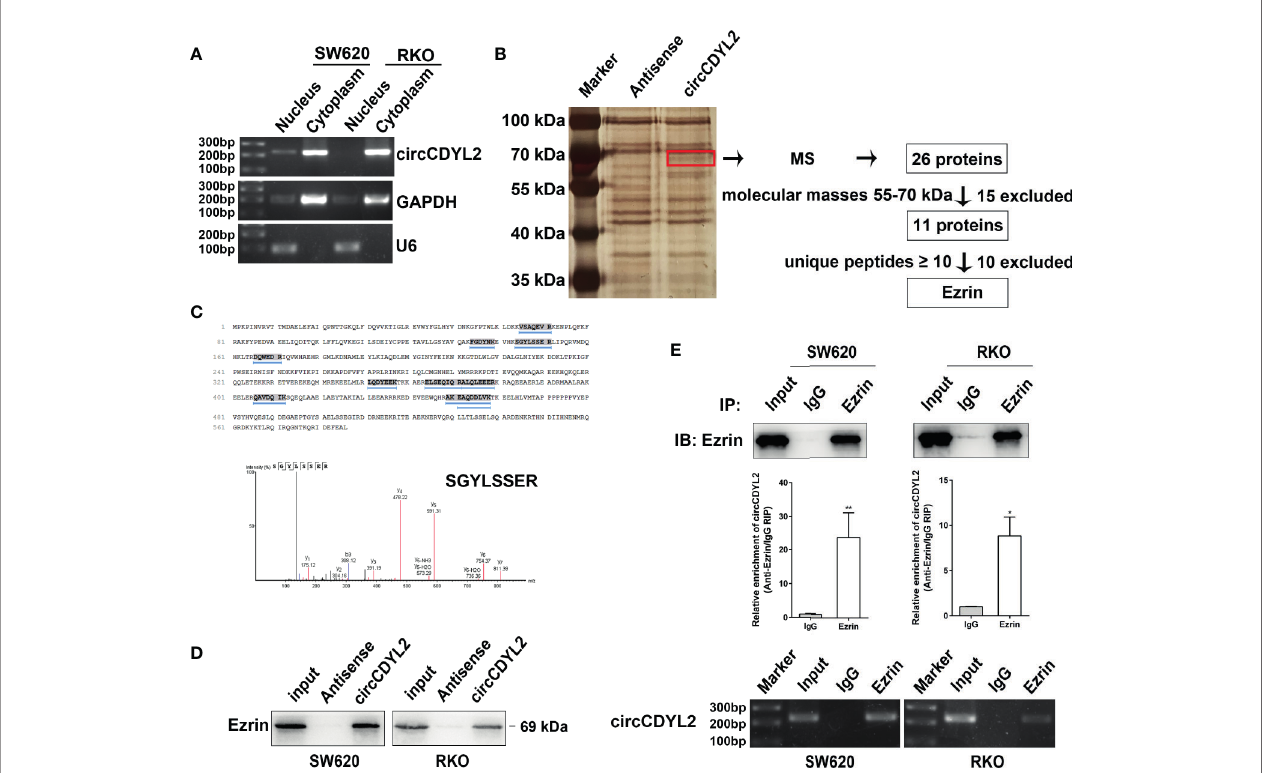
FIGURE 5 | CircCDYL2 mainly resided in the cytoplasm of CRC cells and bound to Ezrin. (A) The nuclear and cytoplasmic distribution of circCDYL2 was con fi rmed using nucleic acid electrophoresis following PCR. GAPDH was mainly localized in cytoplasm while U6 was mainly localized in nucleus. They were used as the quality control of cell fractionation. (B) RNA pulldown assays were used to identify possible target proteins that circCDYL2 could bind to. After silver staining, a differential band marked by red frame was observed in the circCDYL2 group compared to the control. Twenty-six proteins were identi fi ed in this band by MS, and Ezrin was determined to be a candidate target protein of circCDYL2. (C) The amino acid sequences of Ezrin and 10 unique peptides identi fi ed by MS. Below is the peak diagram of peptide. (D) Western blotting following RNA pulldown con fi rmed the binding between circCDYL2 and Ezrin. (E) RT-qPCR and PCR showed enrichment of circCDYL2 following RIP with an Ezrin antibody. * p < 0.05, ** p <